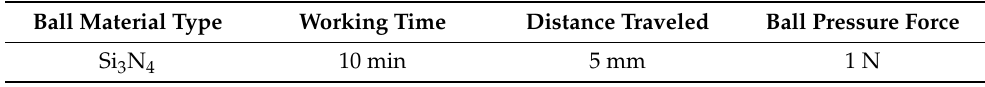
Table 2. Tribological test parameters of the alloy